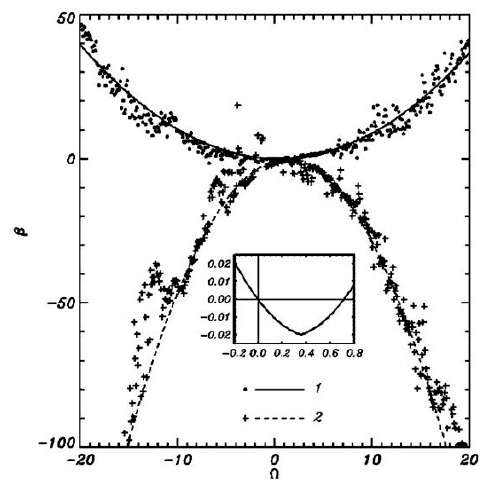
Figure 3. The values the of imaginary (1) and real (2) parts of β -function calculated with (10) and (11). Inset shows the imaginary part of β -function in vicinity of 0.